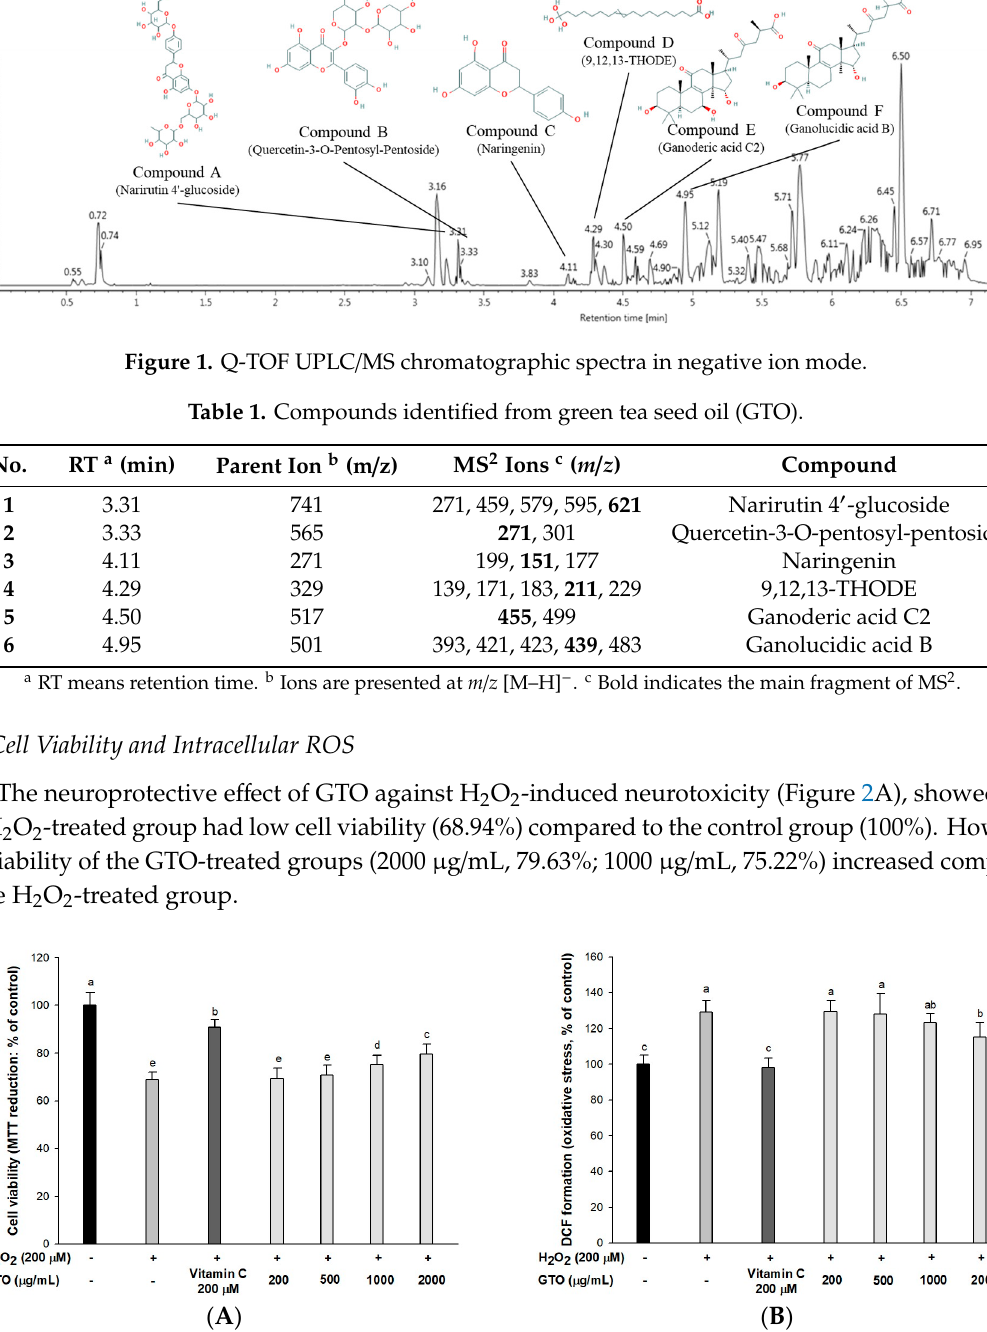
Figure 2. Neuroprotective effect of green tea seed oil (GOT) in PC12 cells. ( A ) Cell viability; ( B ) cellular oxidative stress. Results shown are mean ± SD ( n = 3). Data were statistically represented at p < 0.05, and different lowercase letters indicate statistical significance.